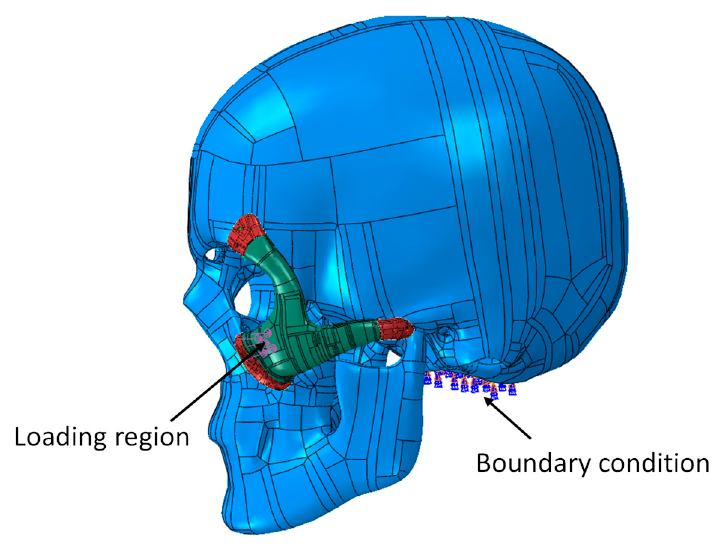
Figure 10. Loading and boundary conditions on the skull and the zygomatic implant.